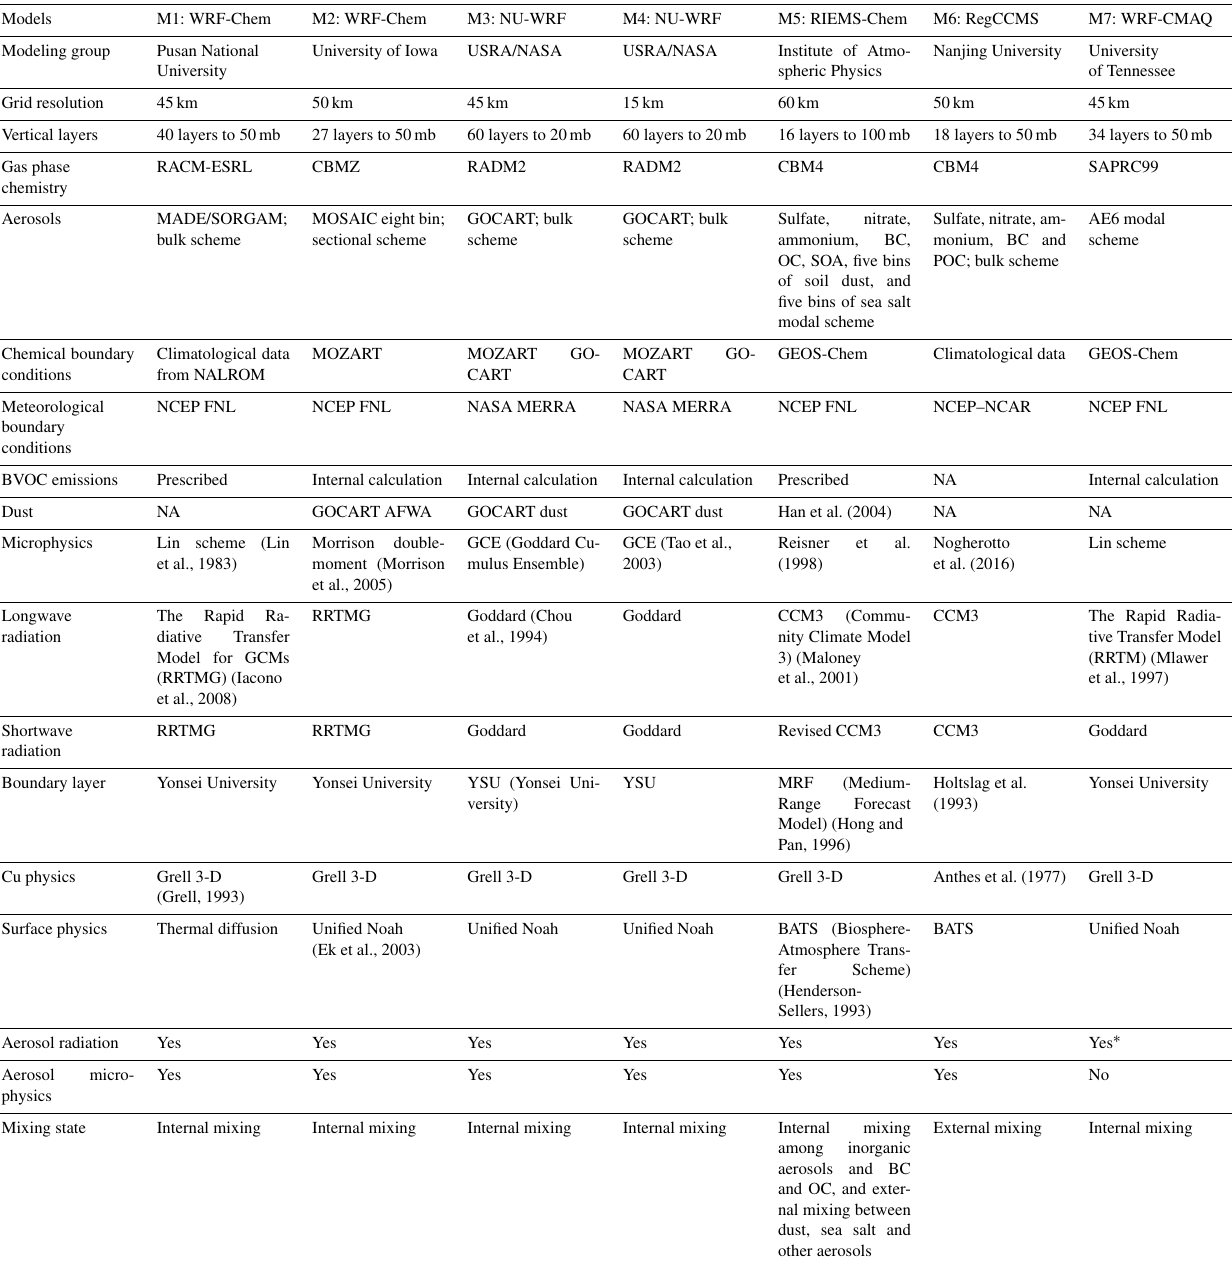
Table 1. Participating models in Topic